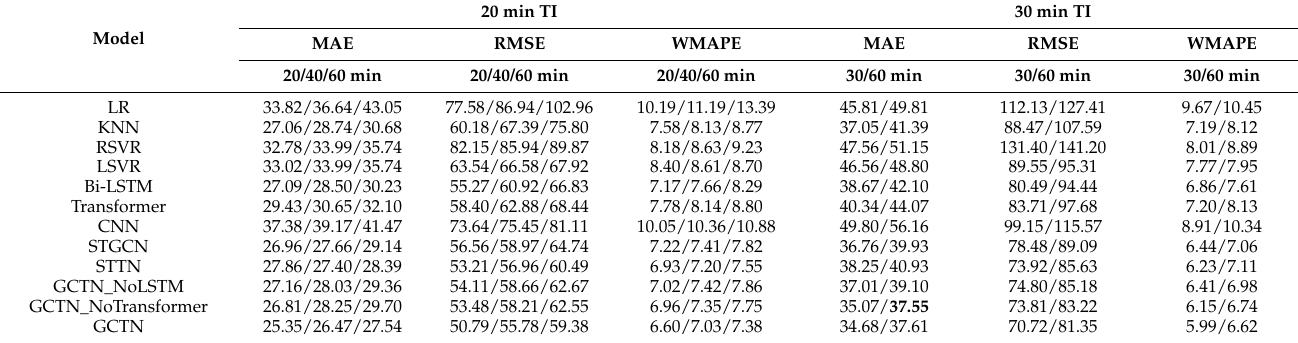
Table 4. Evaluation results of different models and TIs (20 min and 30